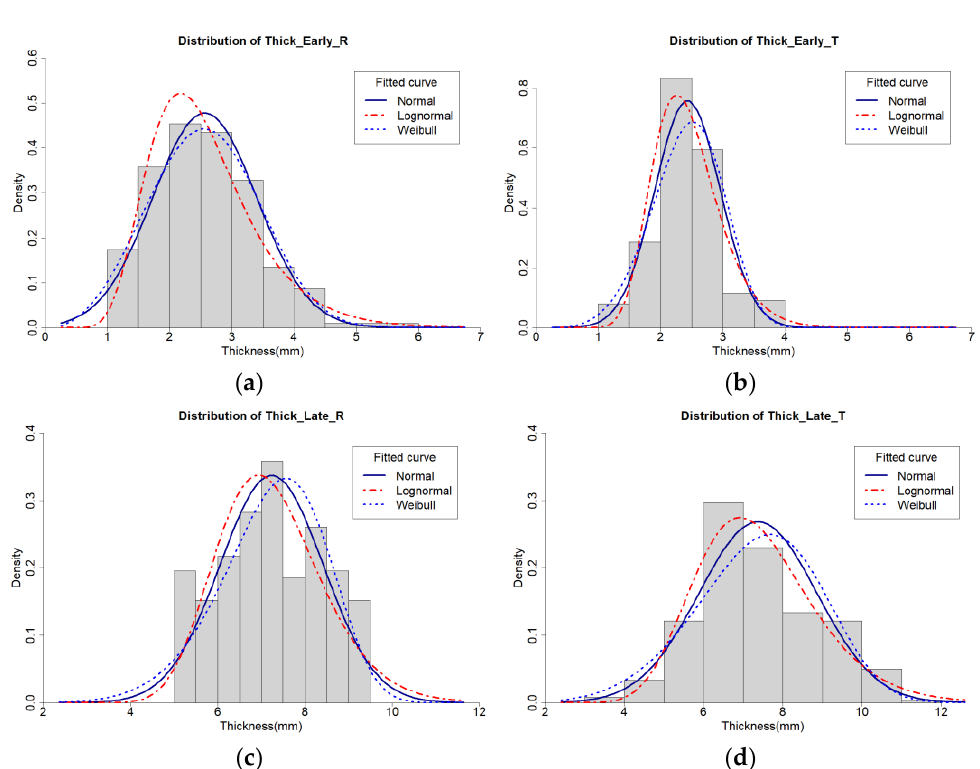
Figure 4. Distribution of cell wall thickness of earlywood and latewood in radial and tangential directions: ( a ) Distribution of thickness of radial earlywood cell wall; ( b ) Distribution of thickness of tangential earlywood cell wall; ( c ) Distribution of thickness of radial latewood cell wall; ( d ) Distribution of thickness of tangential latewood cell wall.